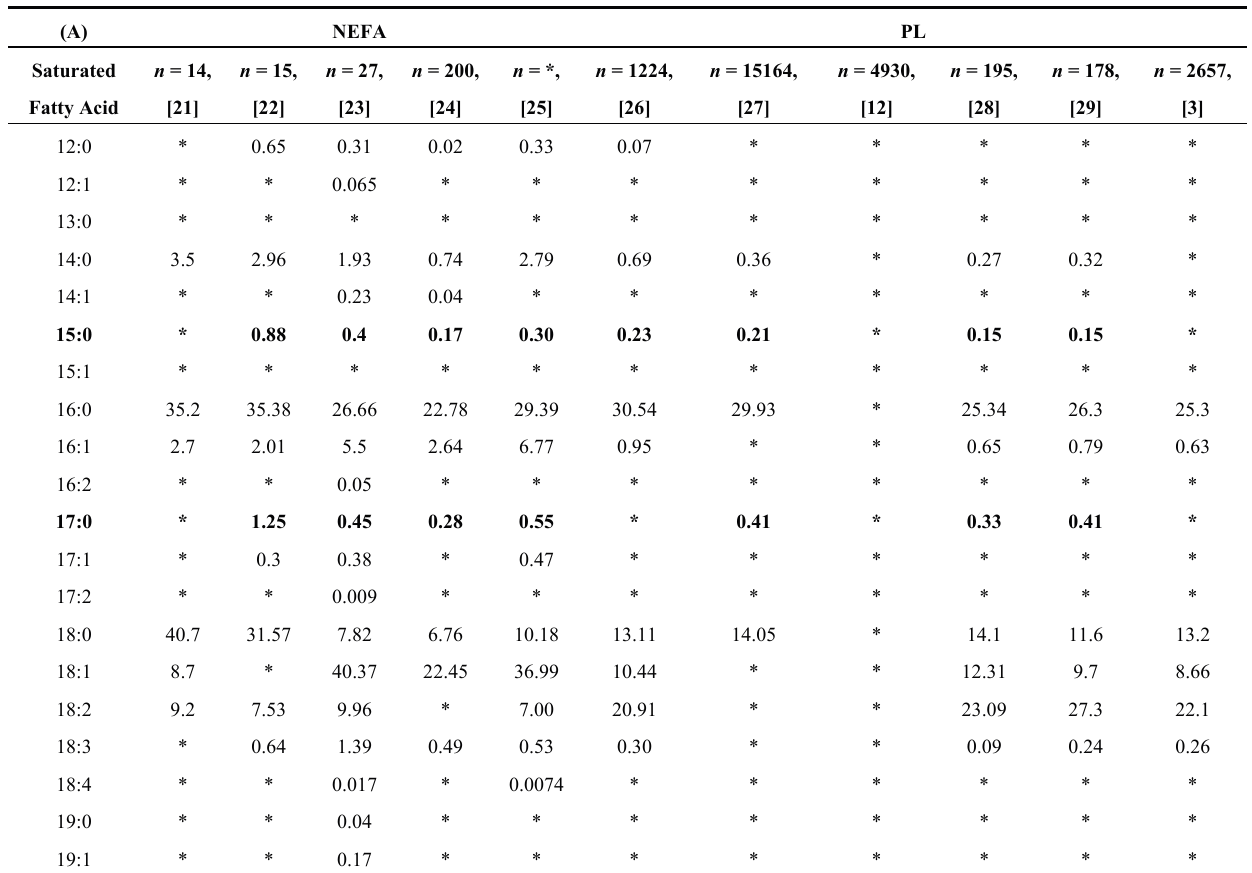
Table 1. ( A , B ) The relative concentrations of plasma fatty acid (12 to 24 number of carbons), within four lipid classes, showing the reported variation in the reporting of fatty acid profiles and the differences in the reported levels of OCS-FAs; NEFA—non-esterified fatty acids (free fatty acids), PL—Phospholipids, CE—Cholesterol esters, GL (TAGs)—Glycerolipids (Triacylglycerols). (A) Different studies showing the relative concentrations in plasma of fatty acids (12 to 24 carbons) with in different lipid classes; NEFA—non-esterified fatty acids (free fatty acids) [21–25], PL—Phospholipids [3,26–29]; (B) Different studies showing the relative concentrations in plasma of fatty acids (12 to 24 carbons) with in different lipid classes; CE—Cholesterol esters [3,25,30–32], GL (TAGs)—Glycerolipids (Triacylglycerols)